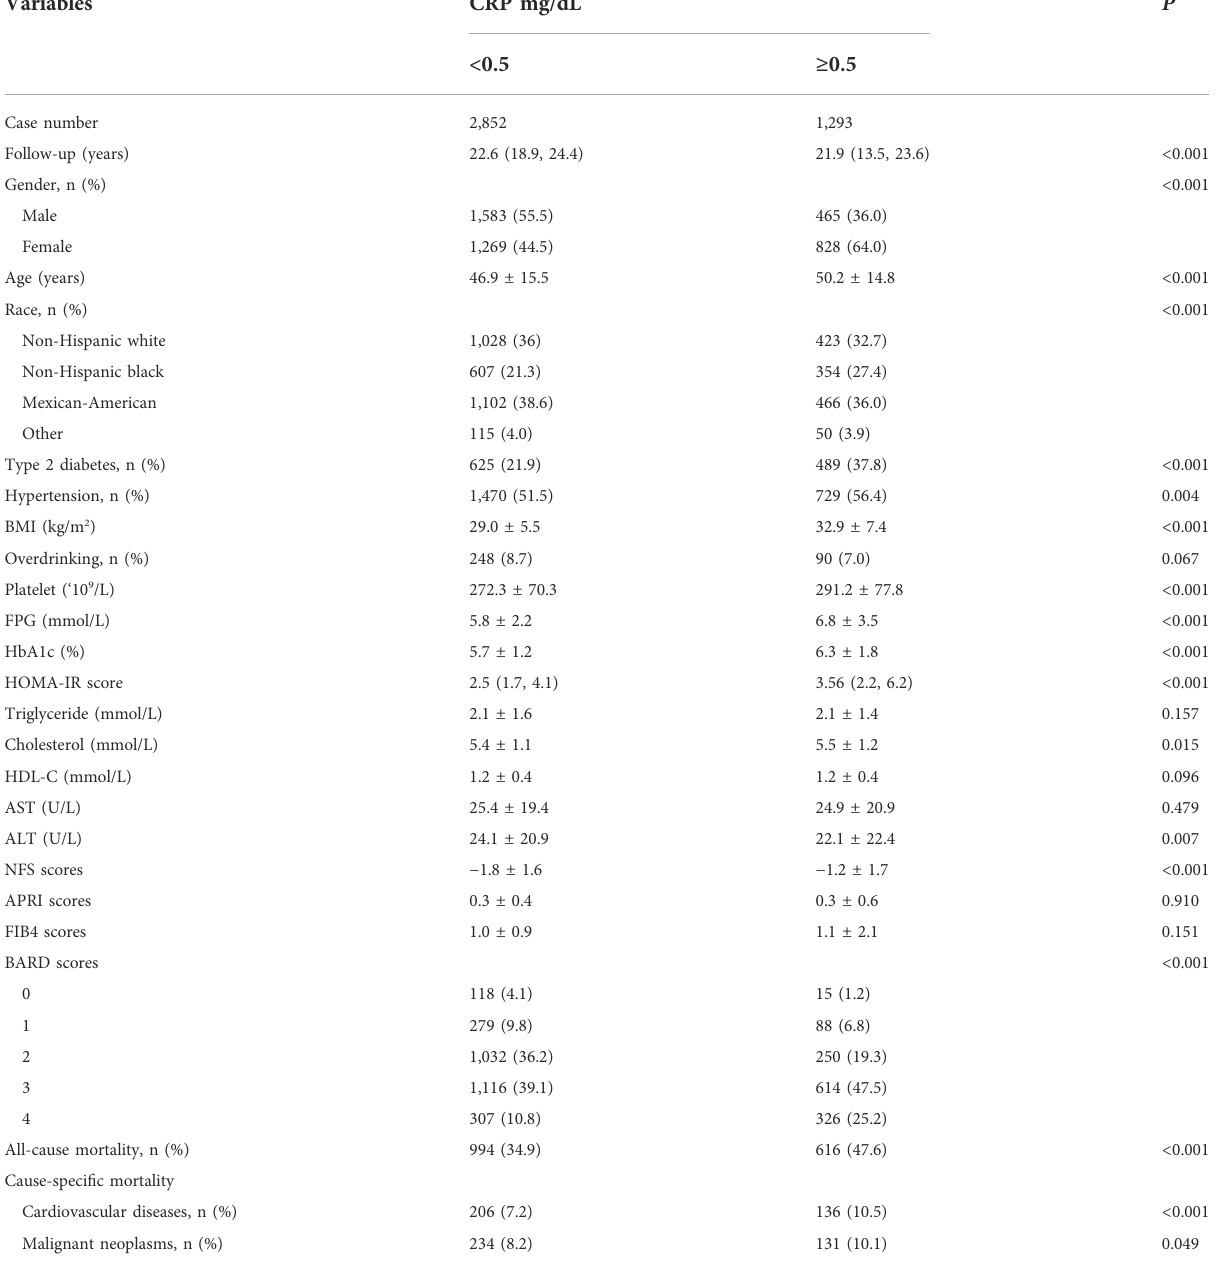
TABLE 2 Comparison between the two hs-CRP concentrations